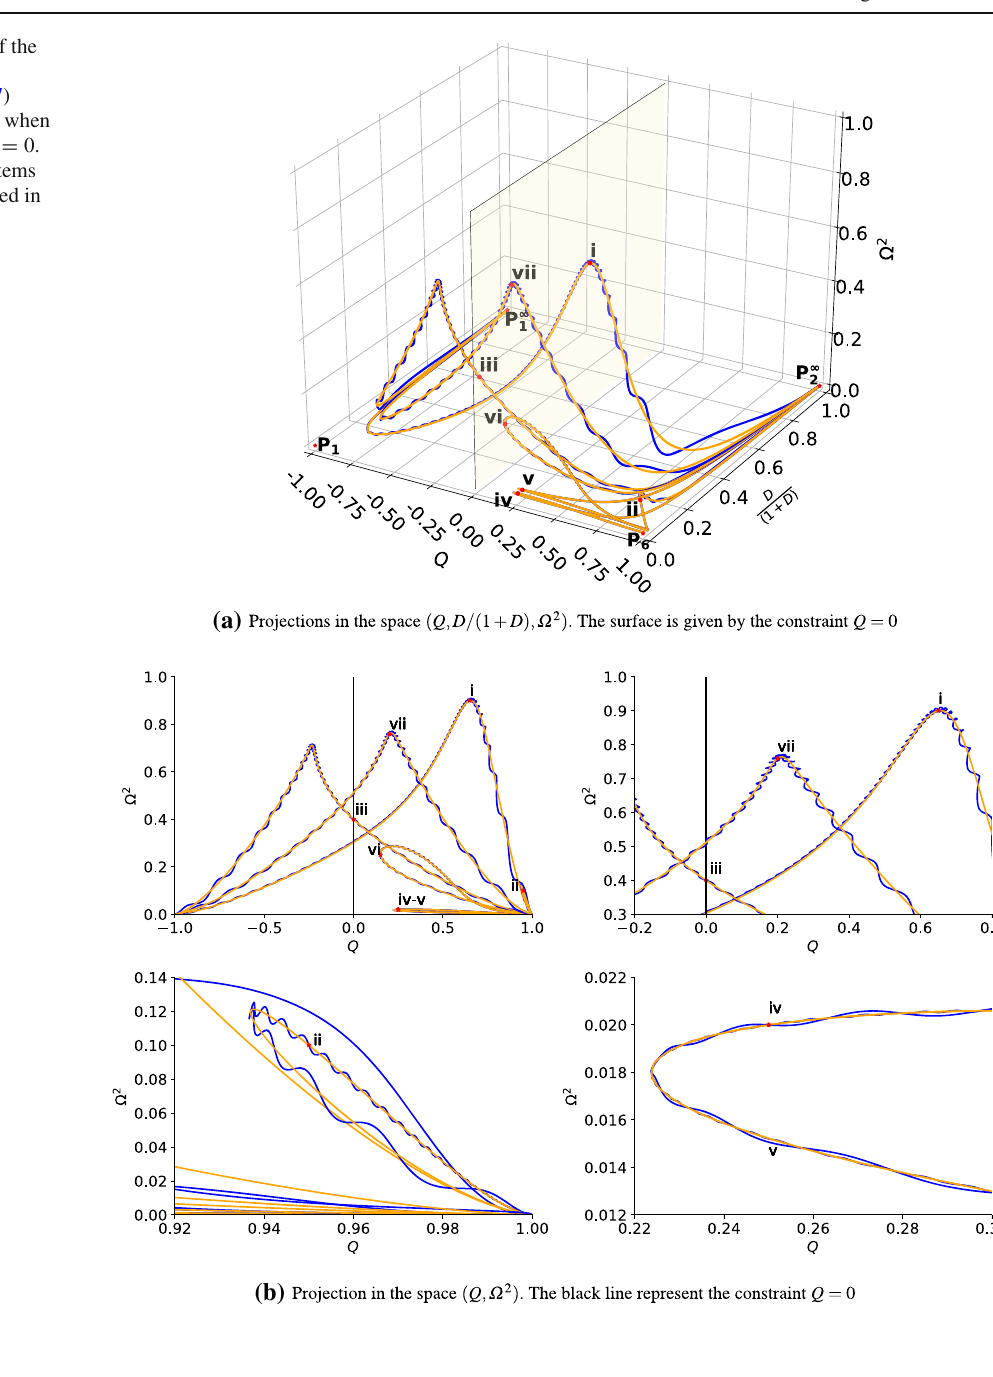
large, the approximation obtained under the assumption of small D